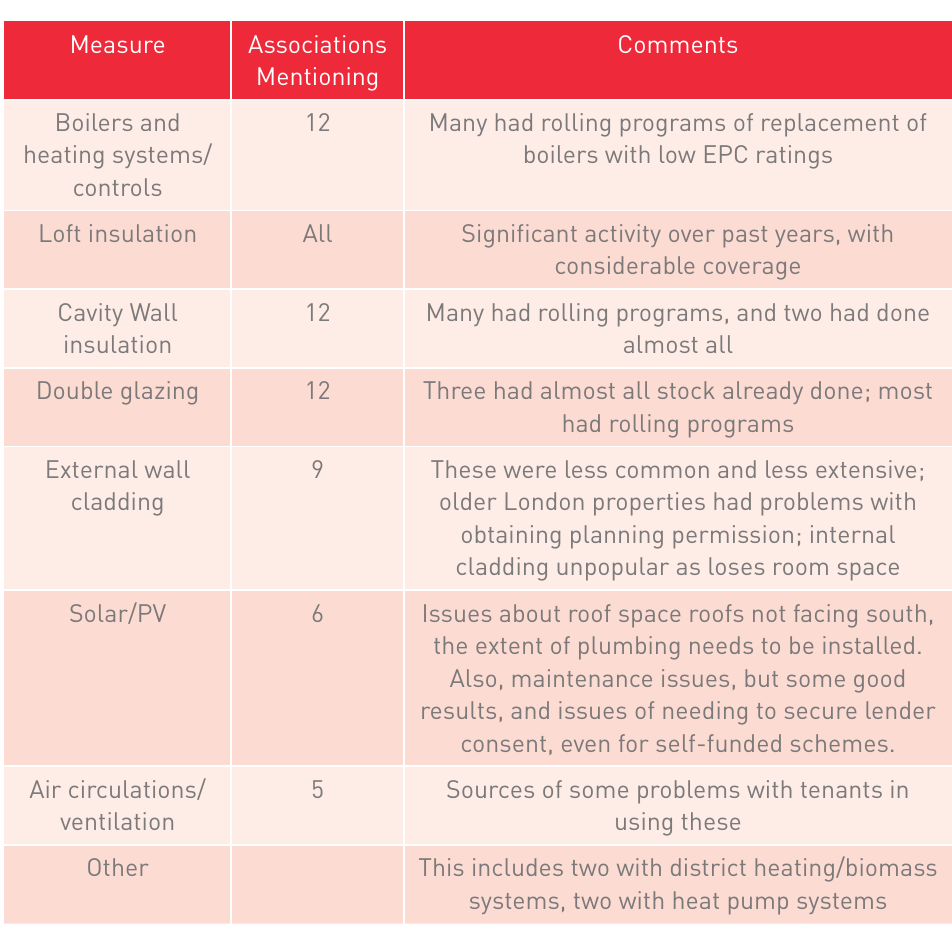
Common Measures of EER in social housing. Source (Provan and Brady, 2015) Measure Associations Mentioning